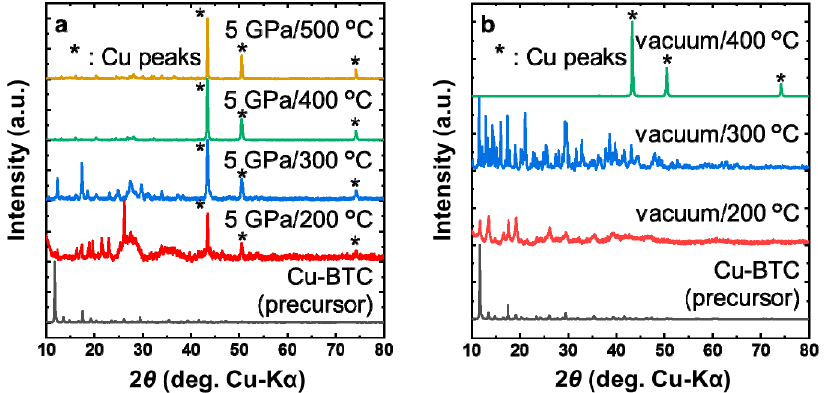
Figure 1. X-ray diffraction patterns of ( a ) the HPHT samples and ( b ) the samples pyrolyzed in the vacuum-sealed glass tubes. The peaks marked with an asterisk (*) at 2 θ = 43.4°, 50.5°, and 74.1° are assigned to (110), (200), and (220) crystalline planes of metallic Cu, respectively.